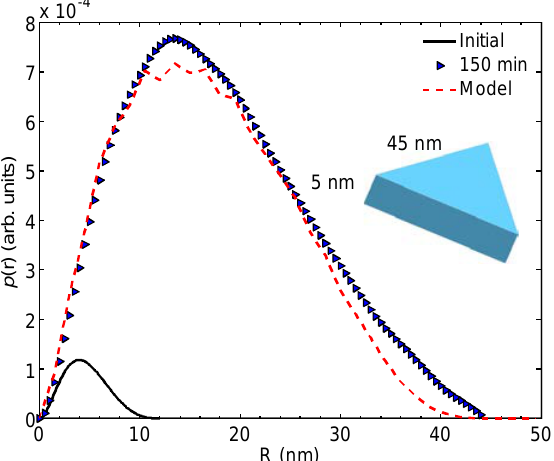
Figure 4. The p ( r ) functions for the initial (solid line) and 150 min solutions (blue triangles) calculated using the GNOM program.